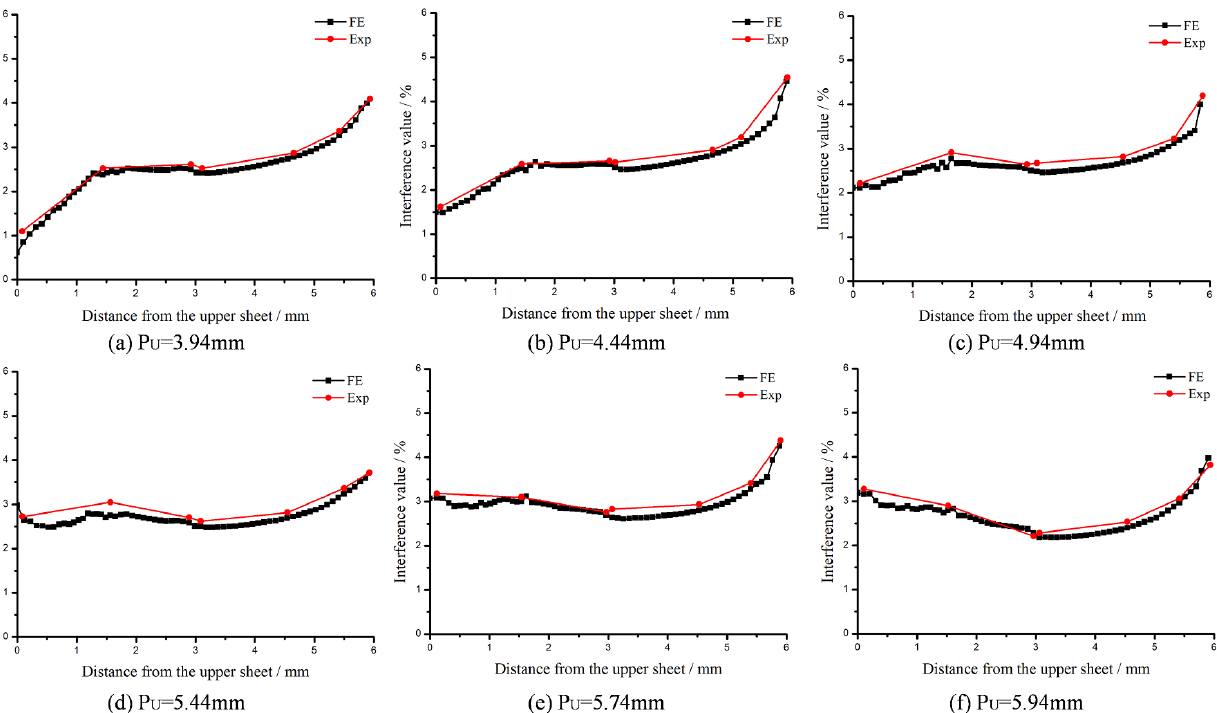
Figure 18. The comparisons of interference condition. ( a ) Pu = 3.94 mm; ( b ) Pu = 4.44 mm; ( c ) Pu = 4.94 mm; ( d ) Pu = 5.44 mm; ( e ) Pu = 5.74 mm; ( f ) Pu=5.94 mm.